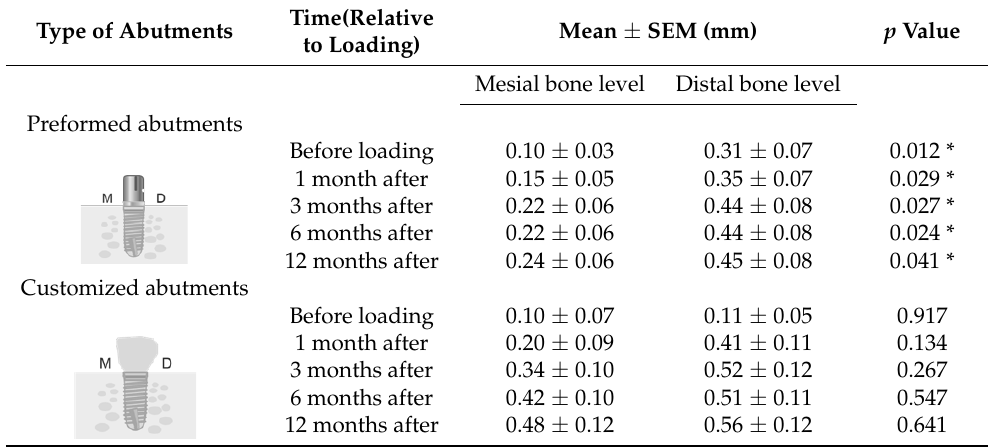
Table 2. Characteristics of the implants.